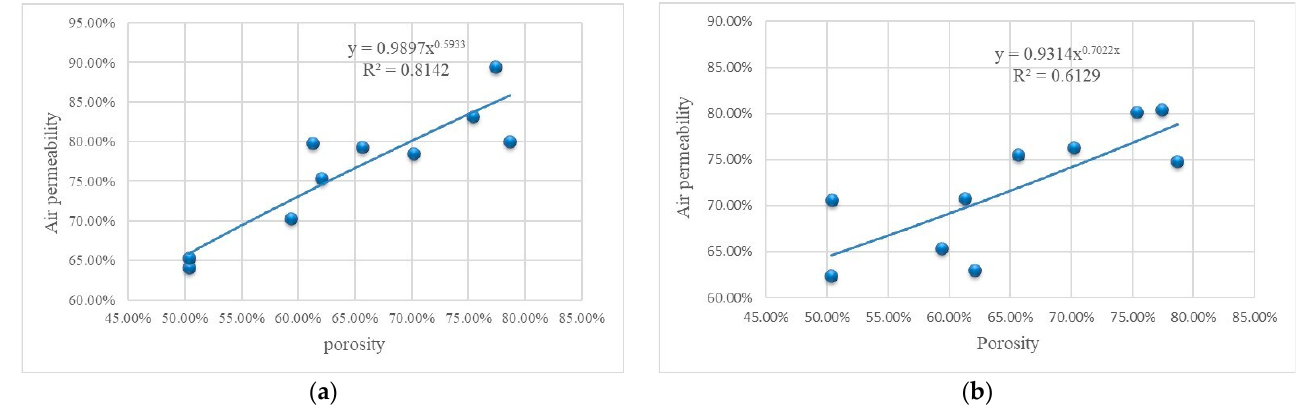
Figure 12. Correlation analysis of porosity calculated using the AdQSM modeling method and digital image analysis method. ( a ) AdQSM modeling method; ( b ) digital image analysis method.